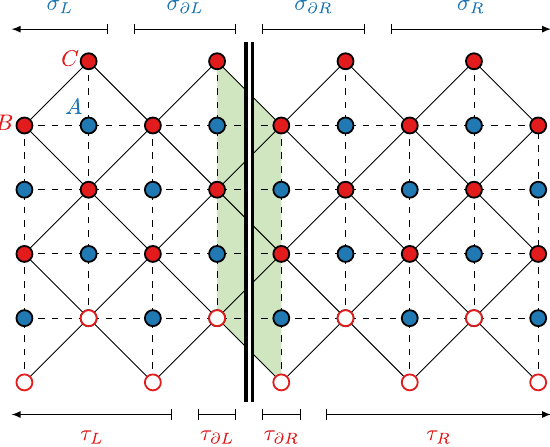
FIG. 7. The Union Jack lattice showing the A sublattice (blue) and BC sublattices (red) on a cylinder. The empty sites on the bottom are identified with the full ones on top, giving a circumference l ¼ 4 . The entanglement cut is denoted with a double line, and the triangles ABC that it breaks are highlighted in green. The top and bottom show the extent of the left, right, and boundary regions for each species of